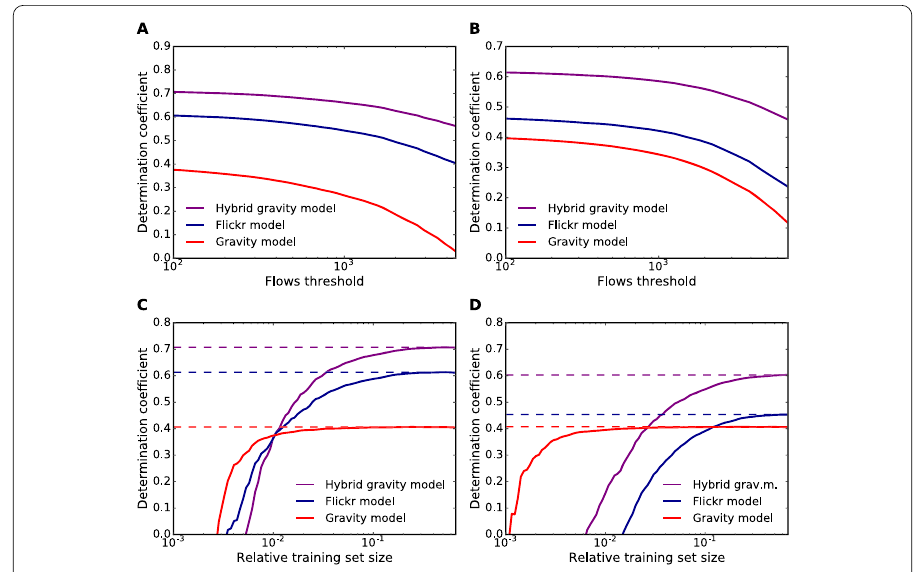
Figure 5 Models’ performance for large flows and under different training set relative sizes. (A) , (B) : Determination coefficient for the prediction of large flows, as a function of the flow threshold. Performance of the models measured by the determination coefficient r 2 when restricted to pairs of nodes for which the real flows are above a given threshold value. (A): Air transportation data. (B): Commuting data. (C) , (D) : Determination coefficient as a function of the training set relative size. The training set sizes were varied in a logarithmic scale. Dotted lines correspond to the maximum attained values. (C): Air transportation data. (D): Commuting